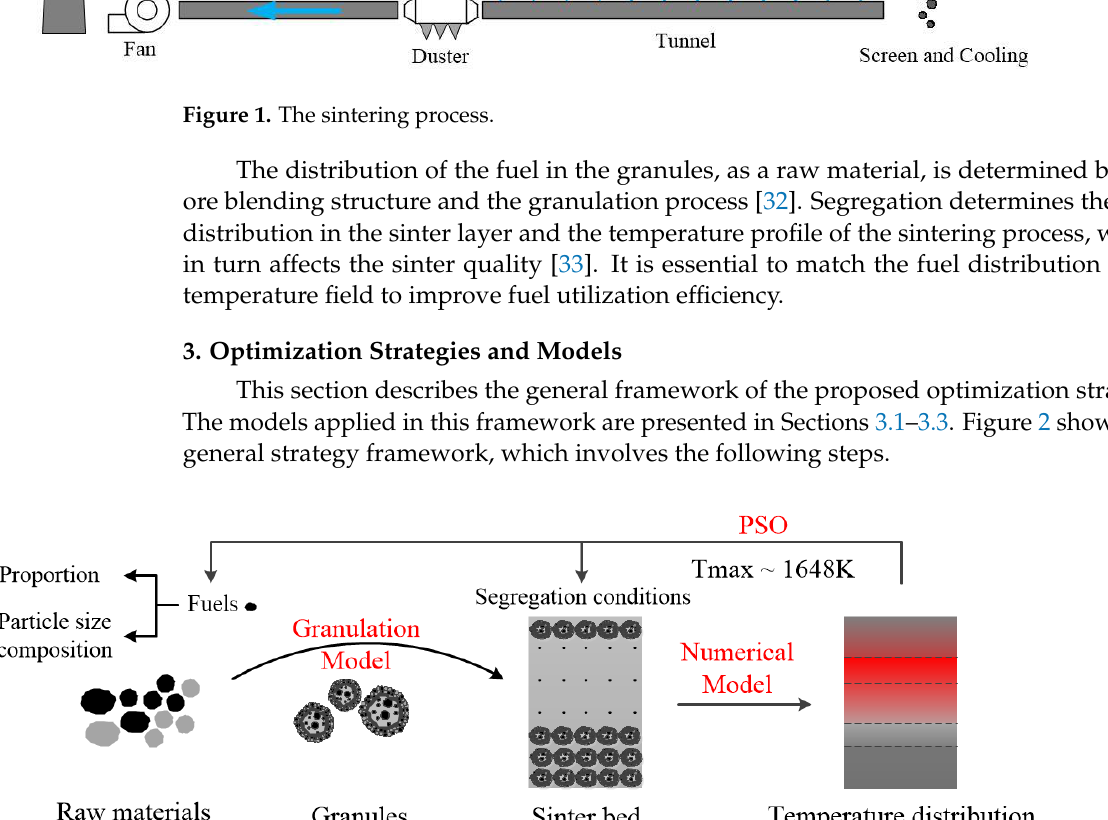
Figure 1. The sintering process.